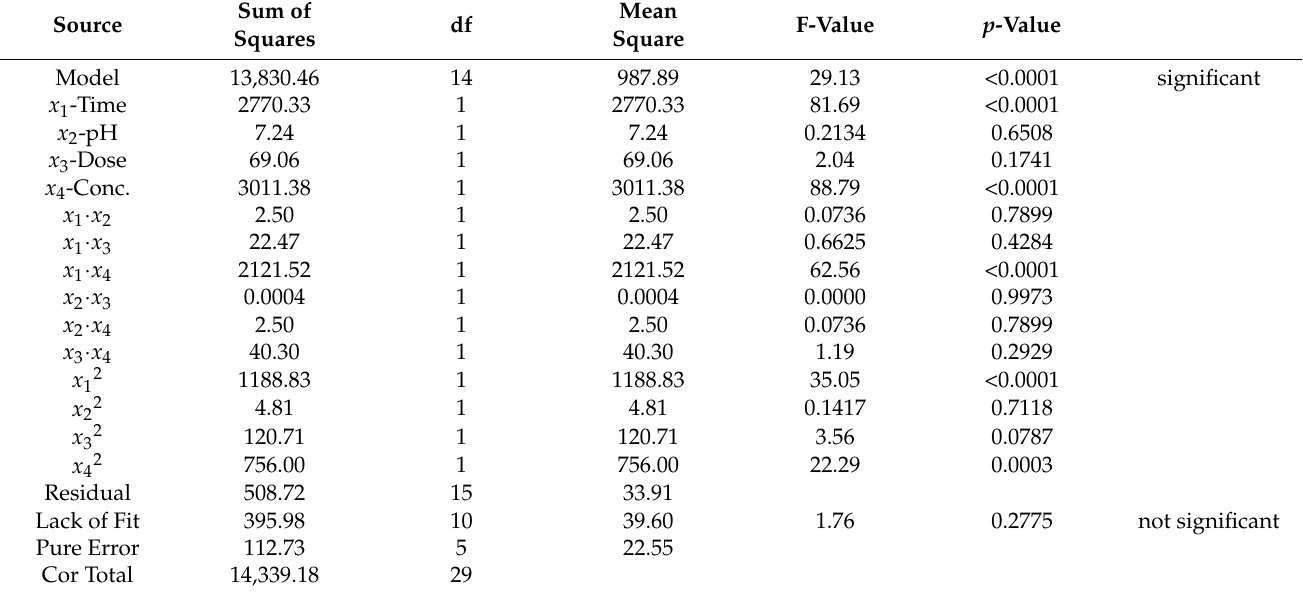
Table 4. ANOVA results for an obtained quadratic model of Equation